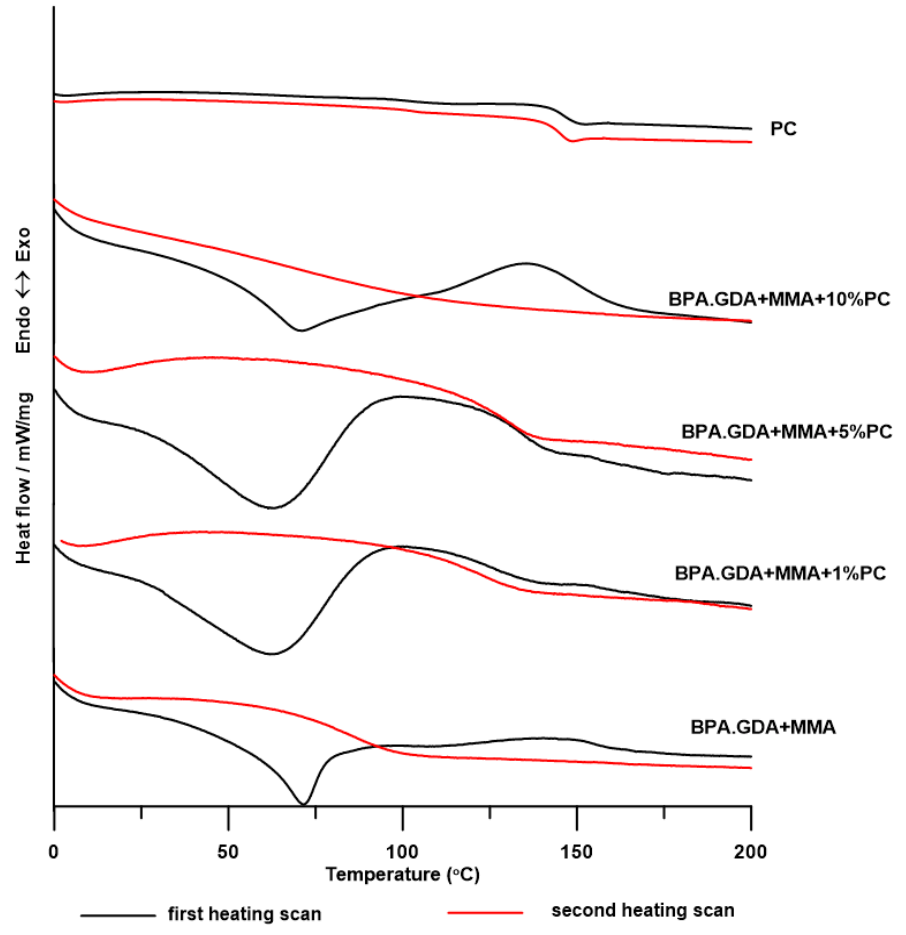
Figure 8. DSC curves of BPA.GDA + MMA blends.